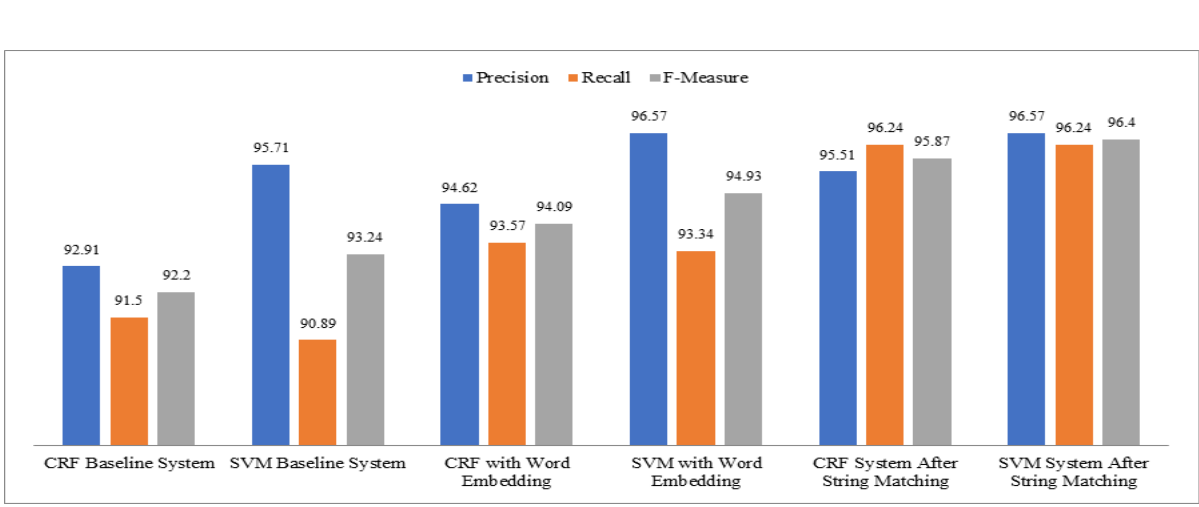
Figure 3. Comparing baseline NER result with word embedding and gazetteer-based string-matching NE